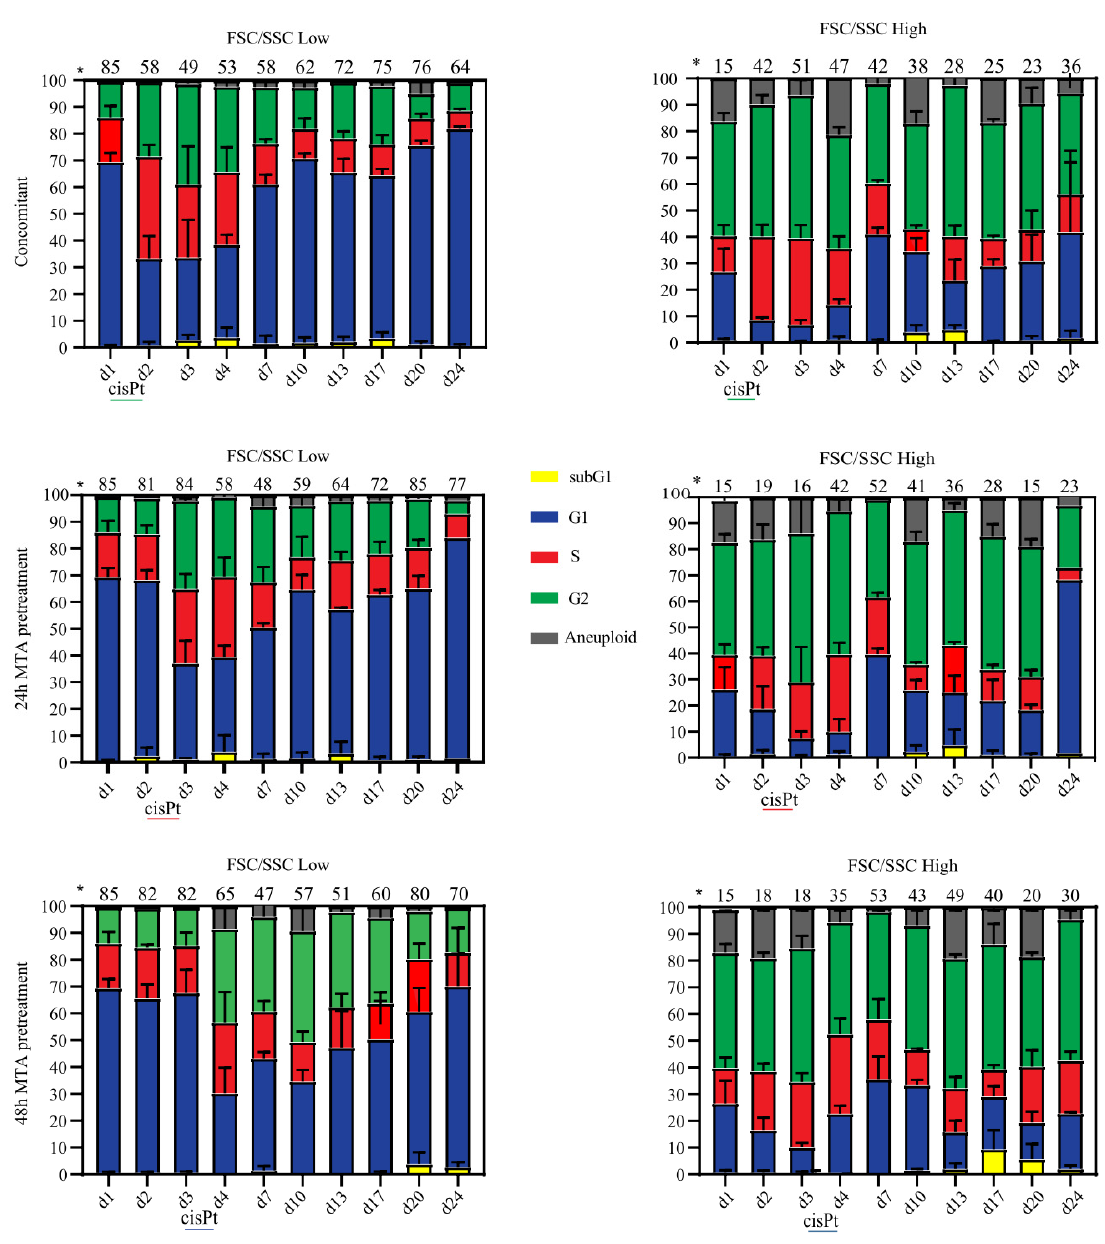
Figure 3. Prolonged MTA pretreatment enhances cisplatin-induced cell cycle arrest. Graphical representation of the cell cycle distribution from cell cultures after different treatment regimens, analyzed by flow cytometry at the indicated time points. Subpopulations featuring either increased forward and side scatter intensity (F/S-high) or low forward and side scatter intensity (F/S-low) were identified as indicated in Figure S2B. Cell cycle analysis was performed as indicated in Figure S2A. The data shown are the mean values and standard deviations of three experiments. * Percentage of the total cell population (mean from three